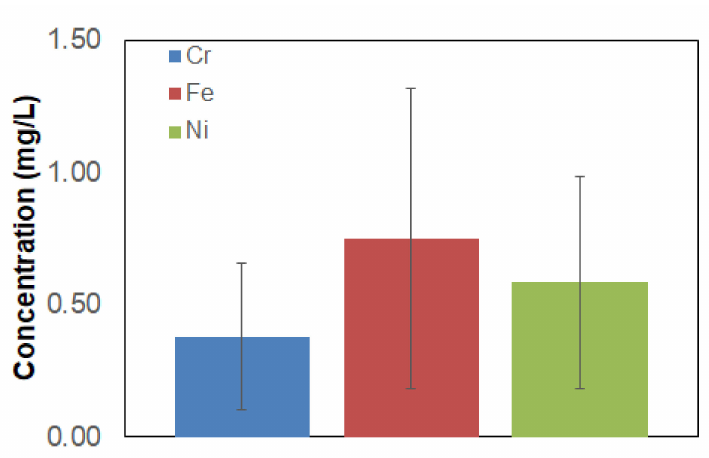
Figure 5. Average concentrations of Ni and Cr during the entire period of pilot scale testing.